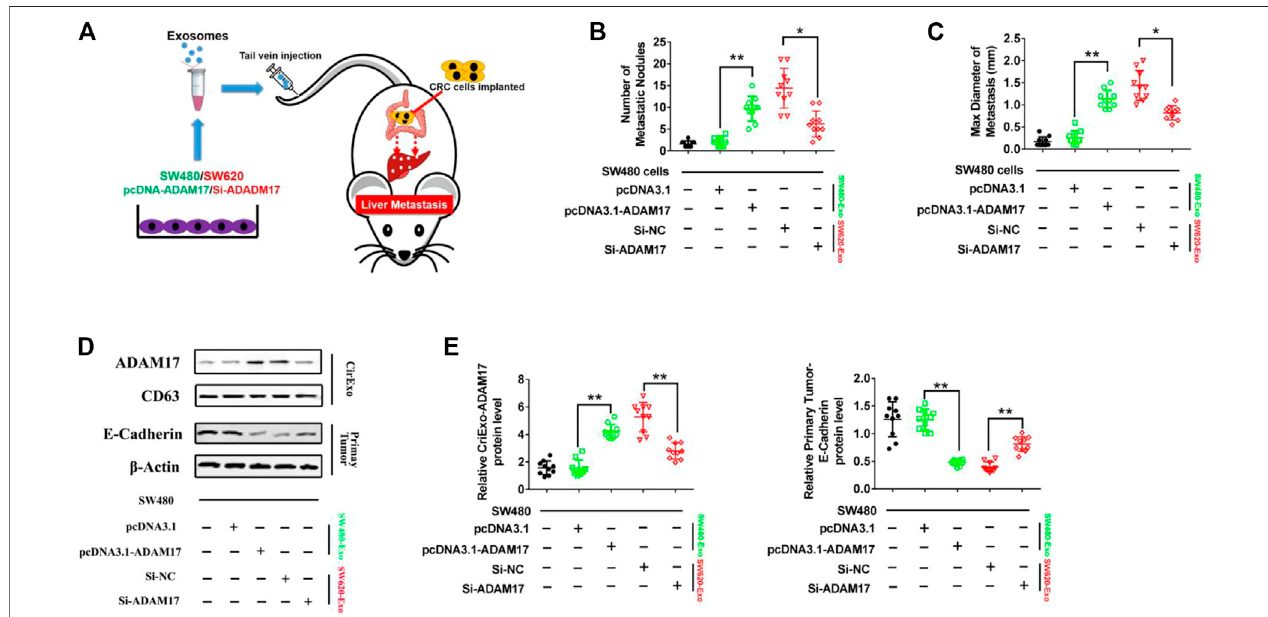
FIGURE 5 | CRC cell-secreted exosomal ADAM17 promotes metastasis in vivo . (A) Schematic description of the experimental design. The pcDNA3.1-, pcDNA3.1-ADAM17-transfected SW480-derived exosomes and Si-NC-, Si-ADAM17-transfected SW620-derived exosomes were isolated. 10 μ g exosomes were used to intravenously inject mice every 3 days for 2 months after the implantation of SW480 cells. (B,C) The number and maximal diameter of metastatic nodules in the livers of SW480-implanted mice treated with pcDNA3.1-, pcDNA3.1-ADAM17-transfected SW480-derived exosomes and Si-NC-, Si-ADAM17-transfected SW620-derived exosomes were calculated and analyzed ( n (cid:2) 10). (D,E) The serum-derived exosomes and primary tumors of SW480-implanted mice treated with pcDNA3.1-, pcDNA3.1-ADAM17-transfected SW480-derived exosomes and Si-NC-, Si-ADAM17-transfected SW620-derived exosomes were collected and lysed for